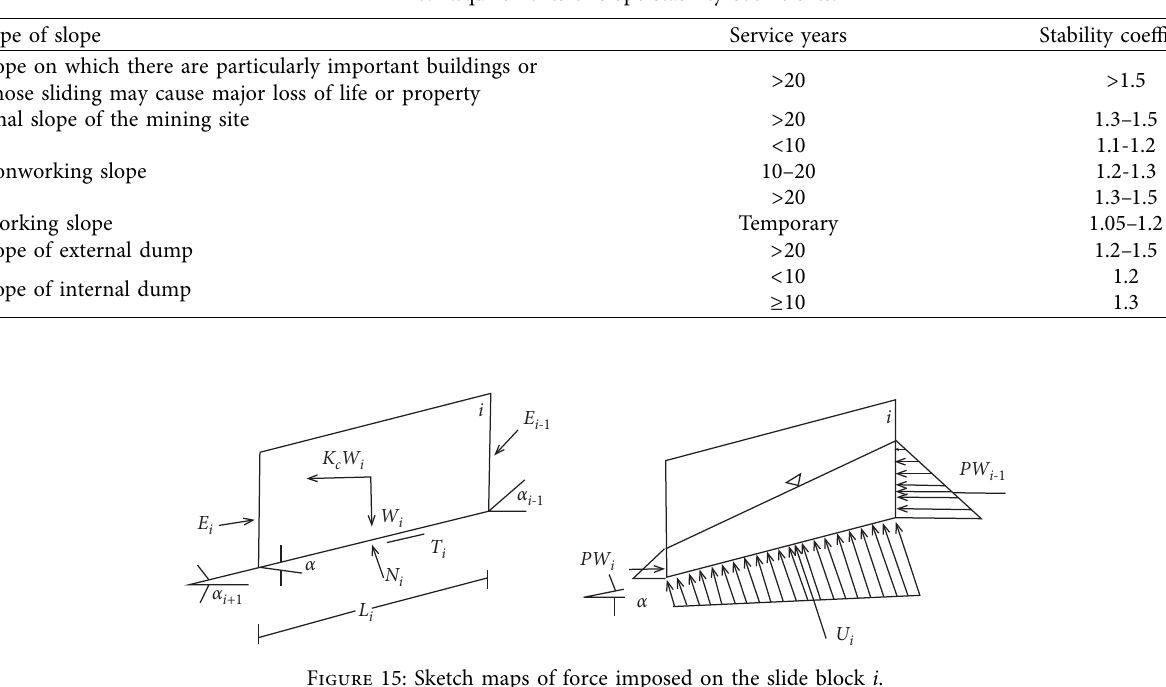
Table 6: Requirements of slope stability